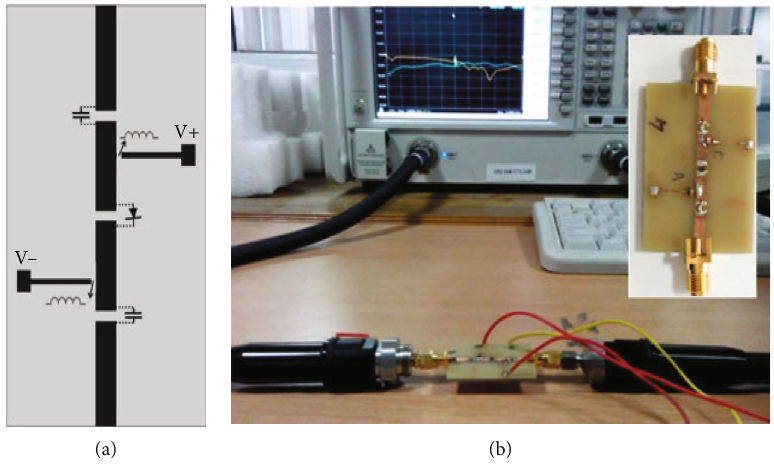
Figure 9: (a) Characterization of PIN diode; (b) experimental